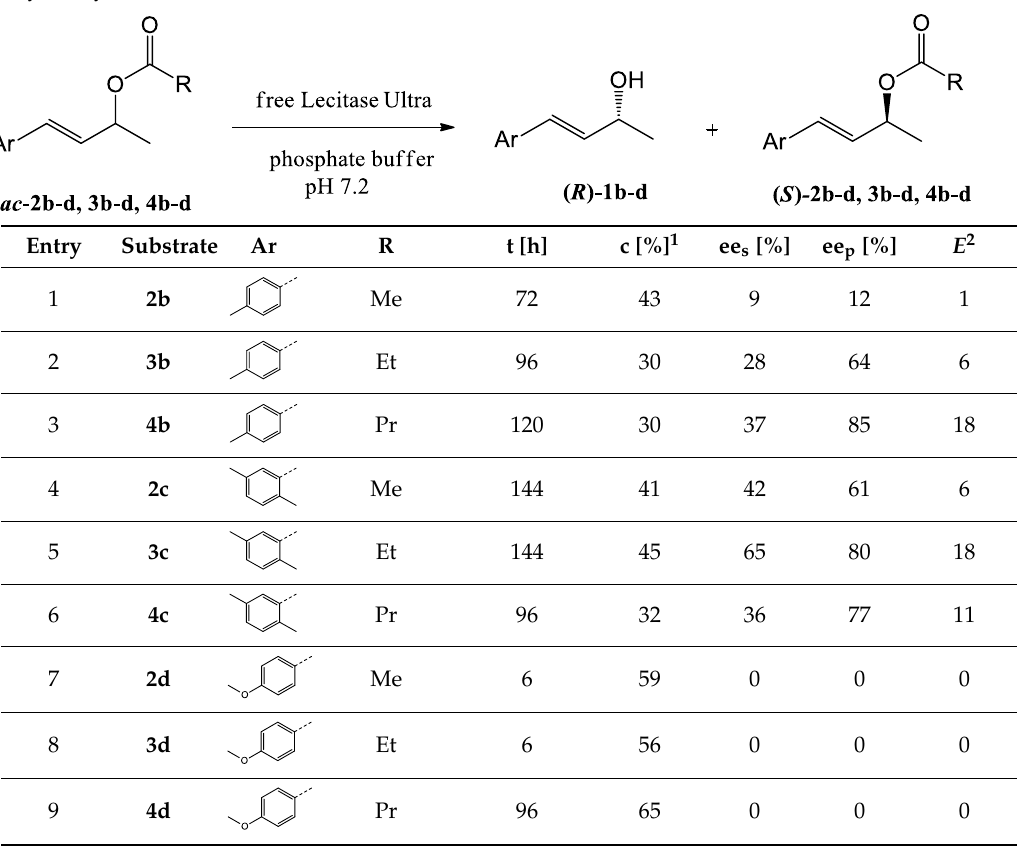
Table 2. Hydrolysis of allyl esters with different phenyl ring substituents 2b–d , 3b–d , and 4b–d catalyzed by free Lecitase ™ Ultra.